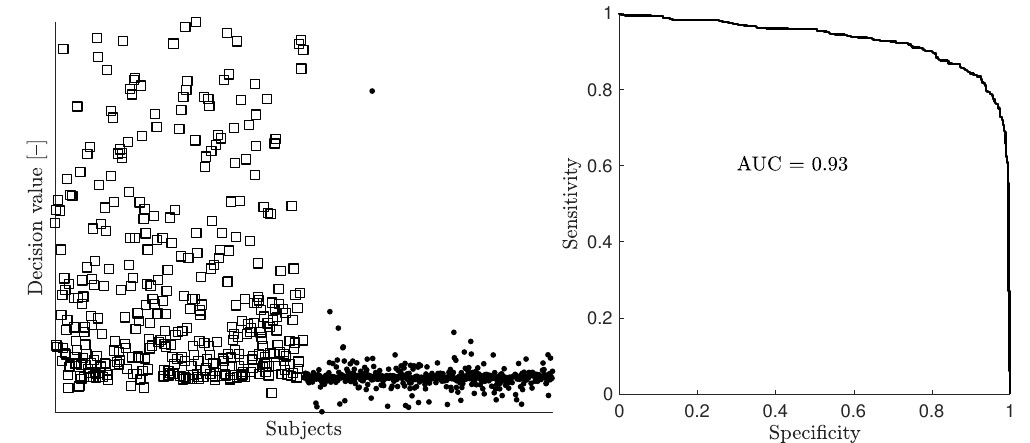
Figure 5. Example of a scatter plot (left) and corresponding ROC/AUC (right) for the full dataset containing 1000 subjects. In the scatter plot, patient models with bleeding ( n = 500) are shown with squares, whereas healthy subjects ( n = 500) are shown with dots. For increased clarity, the y -axis of the scatter plot has been truncated in order to zoom in on the region where the decision values for the majority of subjects fall, while more extreme values for a minority of subjects are not shown.